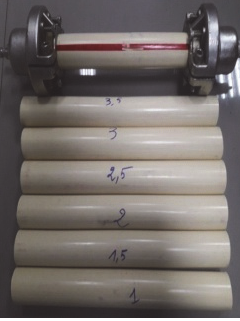
Figure 2: CPVC notched specimens at different depths. Figure 3: CPVC undamaged specimens.